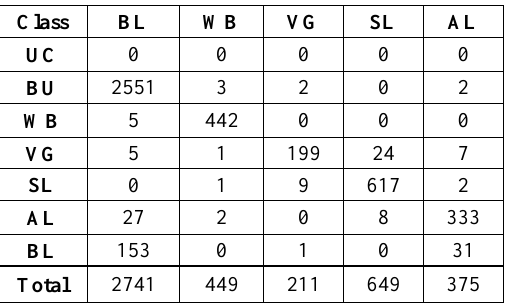
Figure 7. ROC Curve - SVM Table 2. Confusion/Error Matrix of SVM Classifier